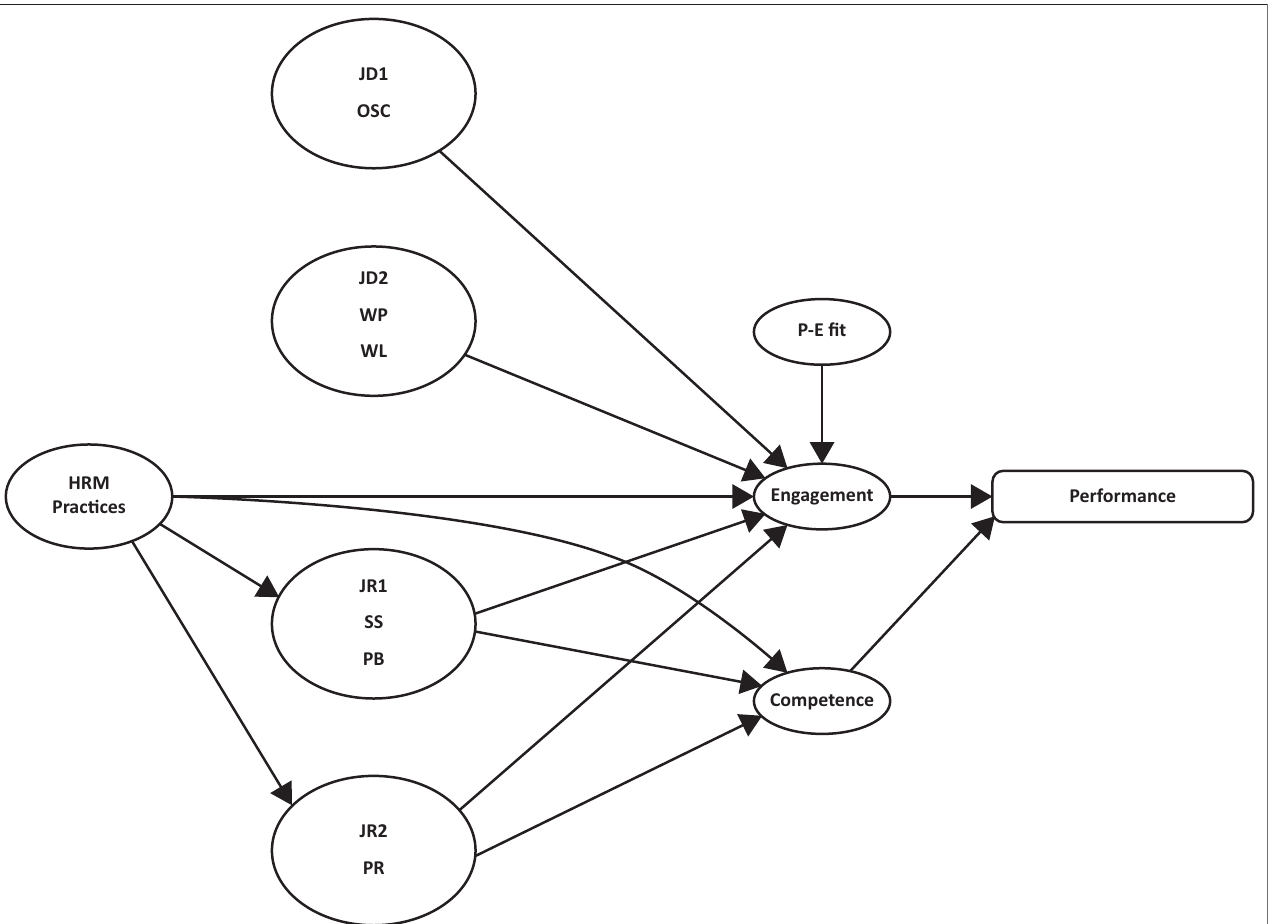
FIGURE 2: Specified Model 2 – Predictors of individual